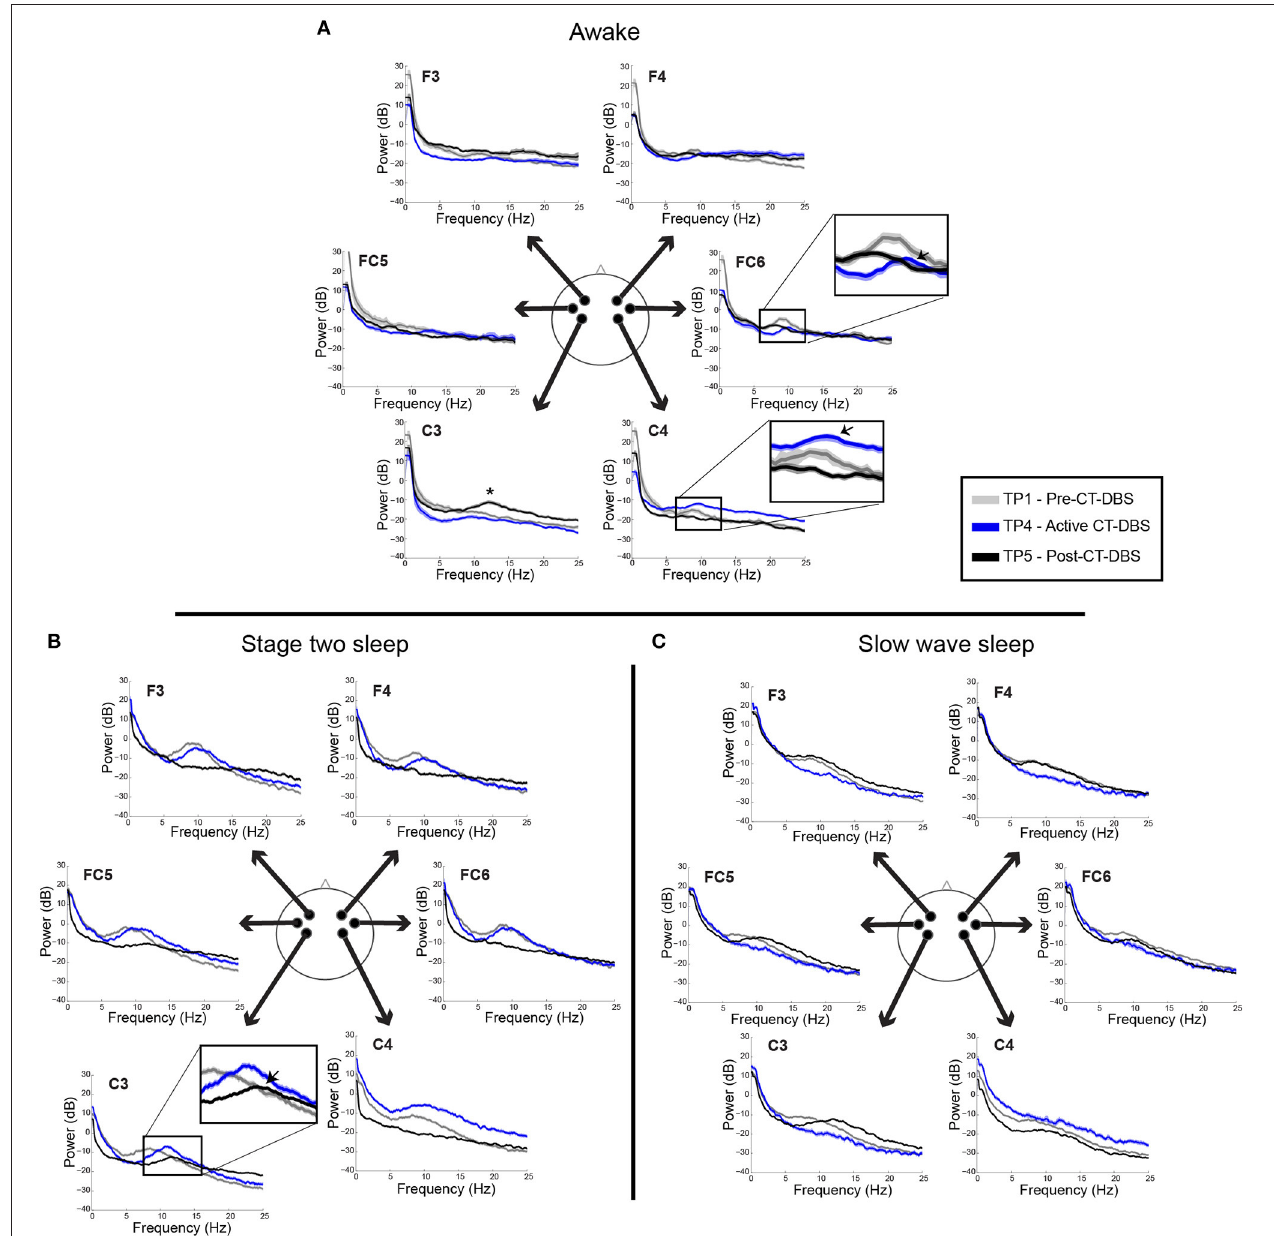
FIGURE 3 | EEG power spectra from time points 1, 4, and 5, corresponding to pre-, active, and post-CT-DBS conditions. (A) Power spectra calculated from resting awake EEG. * Indicates emergence of a “wicket rhythm” ( ∼ 8–13Hz) over the left motor cortex. FC6 and C4 inset arrows denote increases in peak alpha frequency at time point 4. (B,C) Power spectra calculated from non-REM stage two sleep (B) and SWS (C) . Spectral tracings from time point 1 (TP1) are represented by gray lines, time point 4 (TP4) by blue lines, and time point 5 (TP5) by black lines.